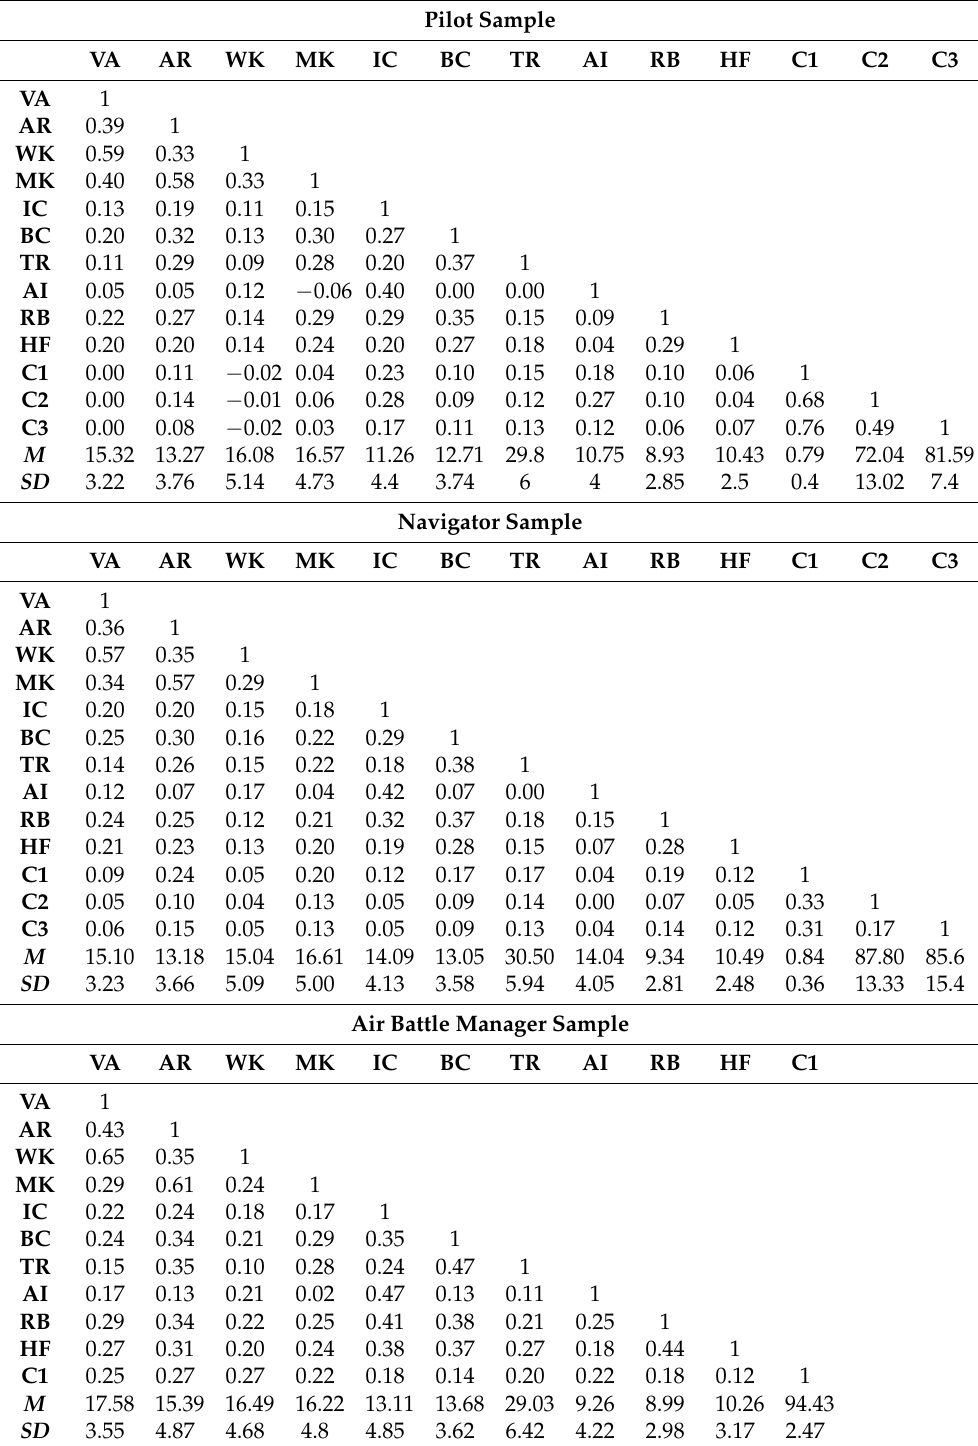
Table A1. Correlations among variables for pilot, navigator, and air battle manager